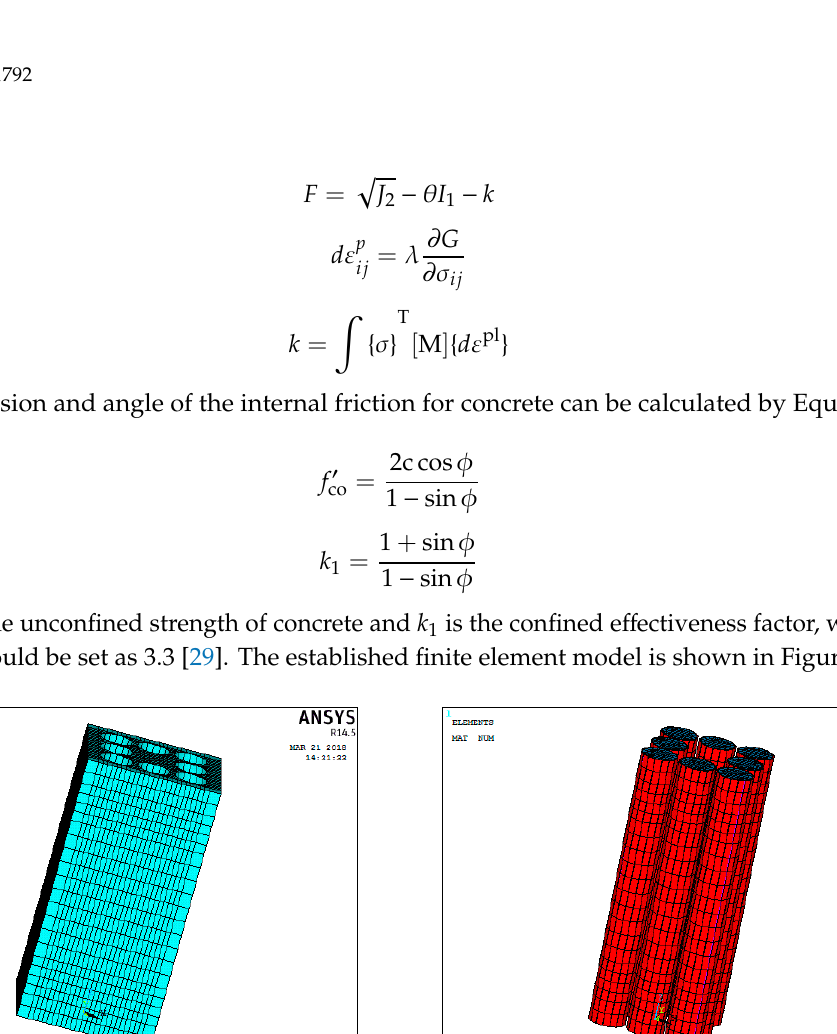
( b ) Figure 11. Comparisons of the failure mode of the tubes: ( a ) specimen T8 and ( b ) specimen T8N.